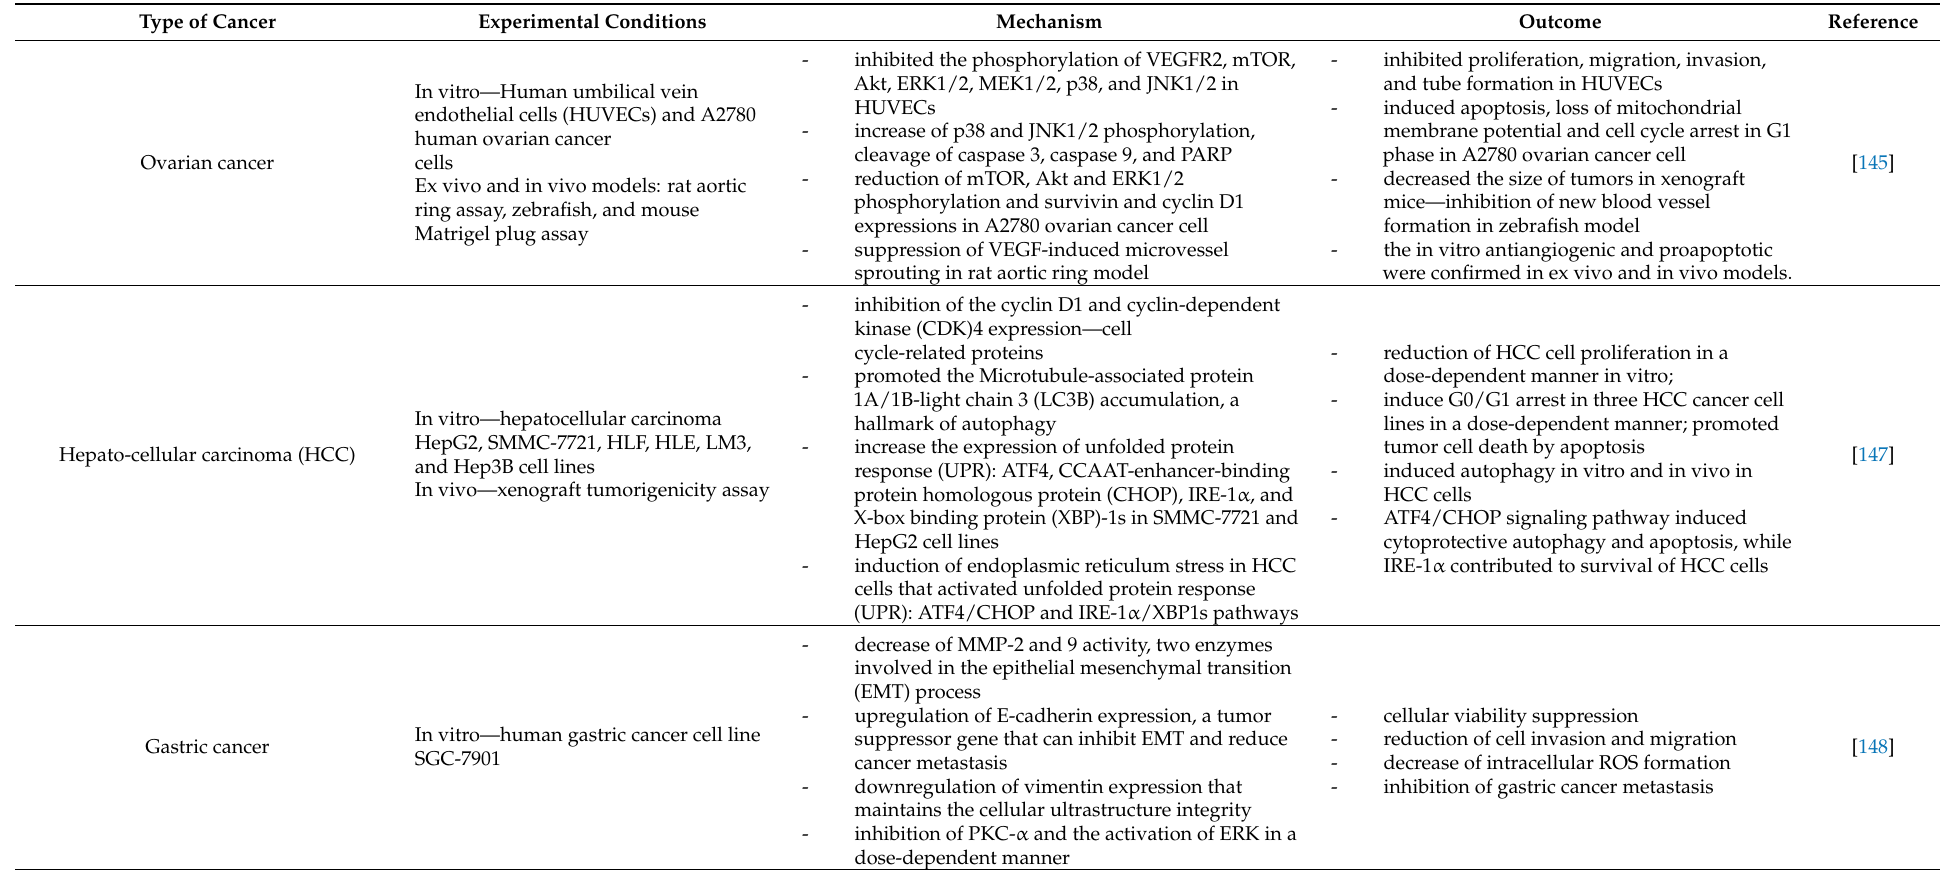
Table 3. In vitro and in vivo biological activity of glycyrrhetinic acid against different types of